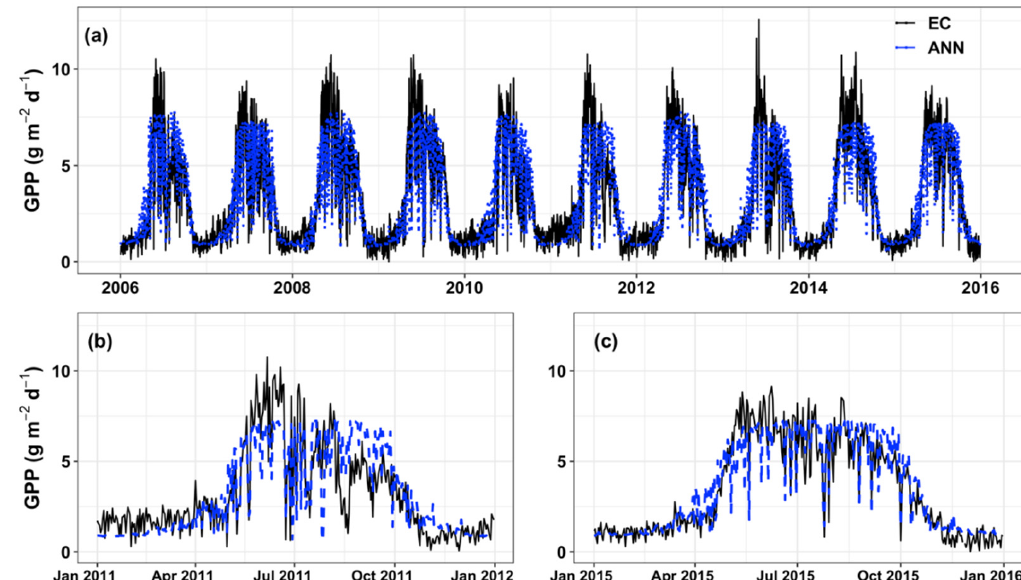
Figure 5. Observed vs. predicted daily gross primary productivity (GPP) by a random forest (RF) model at the Gwangneung site during 2006–2015 ( a ), and the predictions zoomed-in for 2011 ( b ) and 2015 ( c ).